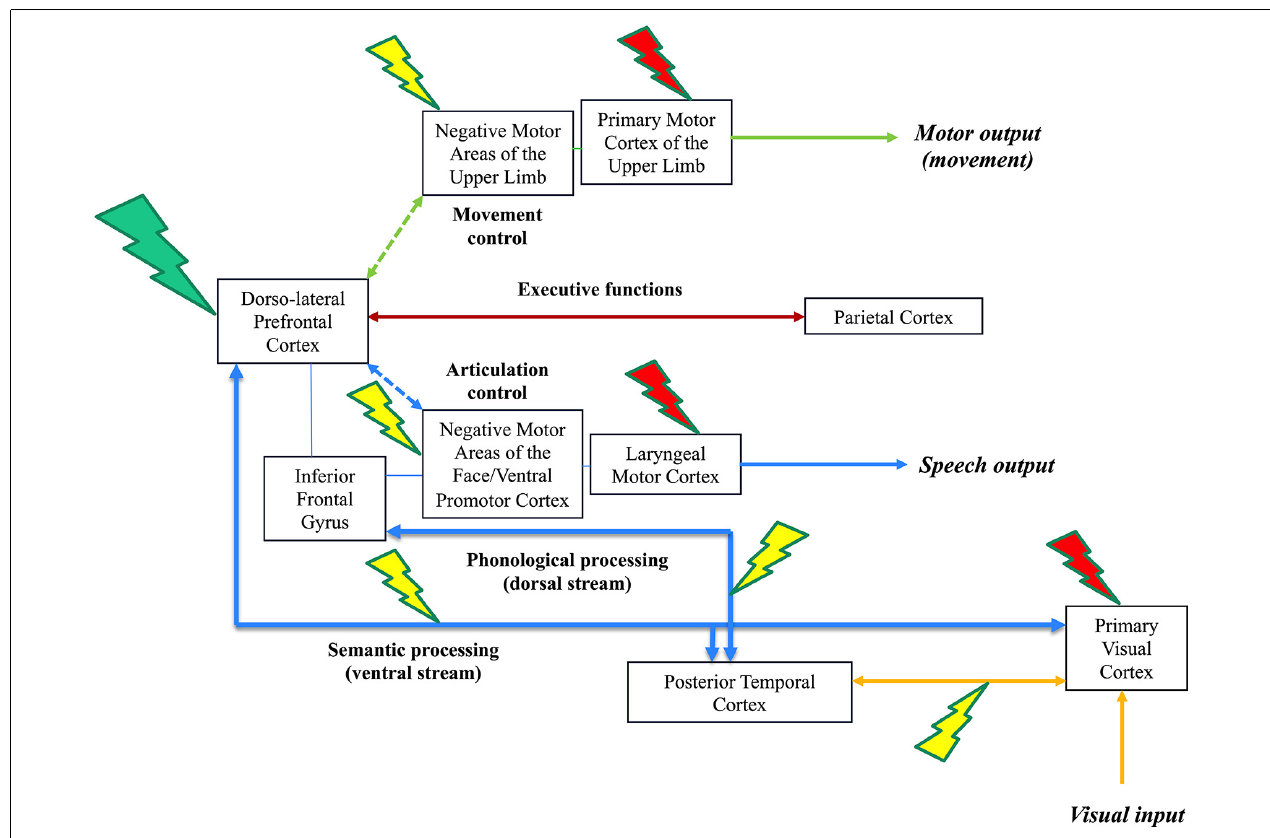
FIGURE 1 | Illustration of the three-level model of direct electrostimulation (DES) neural disruption: red lightning bolt symbolizes the first level (input/output disruption), yellow lightning bolt symbolizes the second level (within-network disruption) and green lightning bolt symbolizes the third level (inter-network disruption). This is a schematic representation of the visual system (lower, connectivity in yellow), speech and language system (lower, connectivity in blue), executive functions system (middle, connectivity in brown) and motor system (upper, connectivity in green) in the left hemisphere of an awake patient who performs a dual-task associating picture naming and movement of the right upper limb. DES of the primary visual system induces phosphenes (1st level, a red lightning bolt at the level of the optic tracts and/or primary visual cortex), while DES of the occipito-temporal connections induces visual hemiagnosia [2nd level, a yellow lightning bolt over the posterior inferior longitudinal fasciculus (ILF)]. In parallel, the patient can continue to move the right upper limb. In the speech and language system, DES of the laryngeal motor cortex elicits involuntary vocalization (1rst level, red lightning); DES of the ventral premotor cortex and frontoparietal articulatory loop (not shown) elicits speech apraxia/arrest (anarthria); while DES of the dorsal phonological route induces phonemic paraphasia and DES of the ventral semantic route induces semantic paraphasia (2nd level, red lightning). Of note, stimulating both dorsal and semantic streams may generate complete anomia. In parallel, the patient can continue to move the right upper limb. In the motor system, DES of the primary motor cortex of the upper limb and its corticospinal tracts (motor execution, output) causes an involuntary movement (1st level, red lightning); DES of the negative motor cortex (movement control) and its fibers (not shown) generates an arrest of movement (2nd level, yellow lightning). In parallel, the patient can continue to perform the picture naming task. During DES of the dorsolateral prefrontal cortex (integrative hub), the brain is not able to coordinate its networks (including the frontoparietal connections involved in the executive functions and then the goal maintenance), the patient cannot achieve dual-task anymore: the patient is only capable to perform each task separately, naming or upper limb movement, but not both simultaneously (3rd level, green